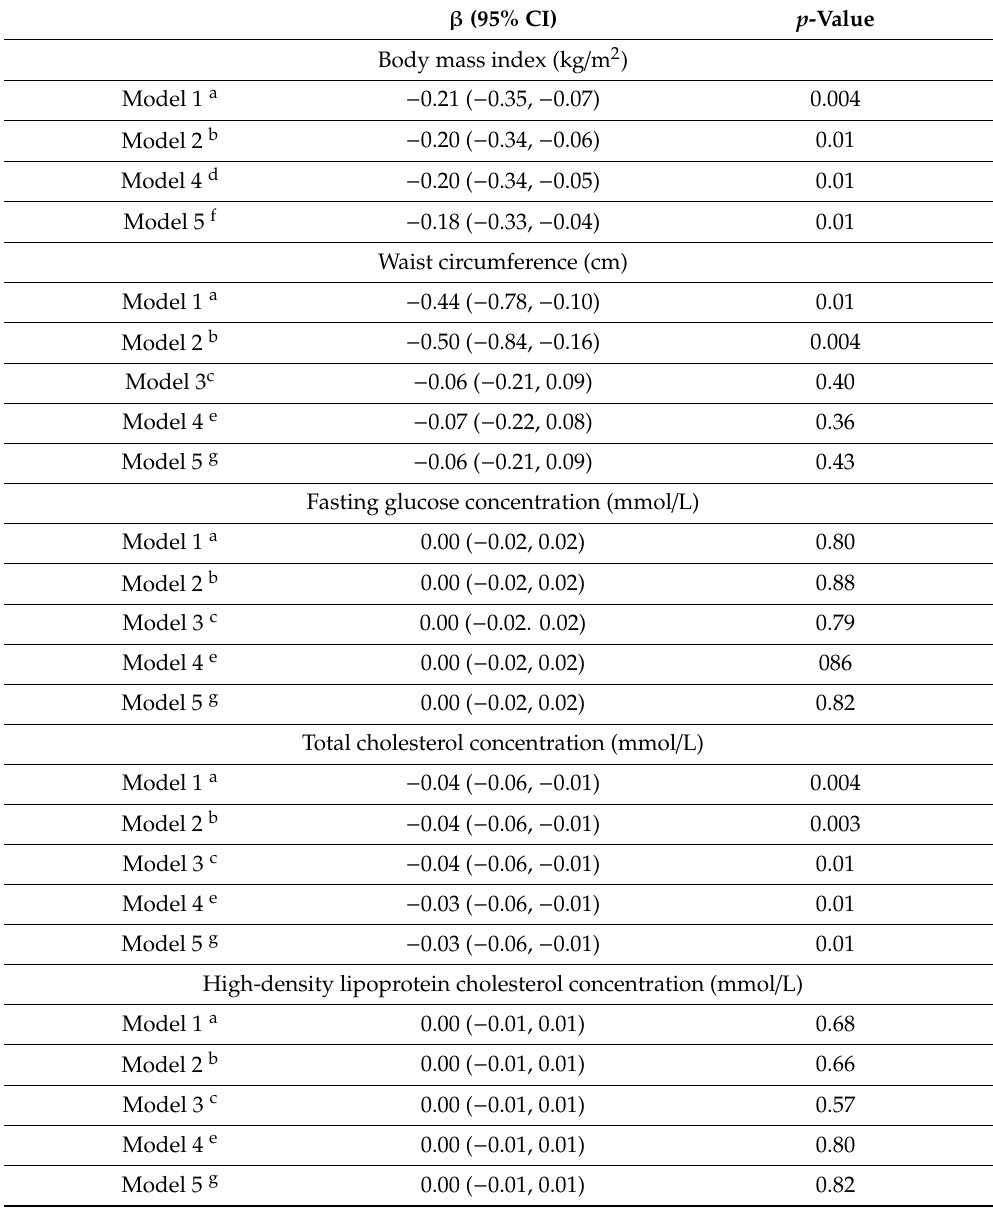
Table 3. Multiple linear regression analysis of association of breakfast frequency and risk factors of cardiovascular disease independent of potential confounding among participants ( n =